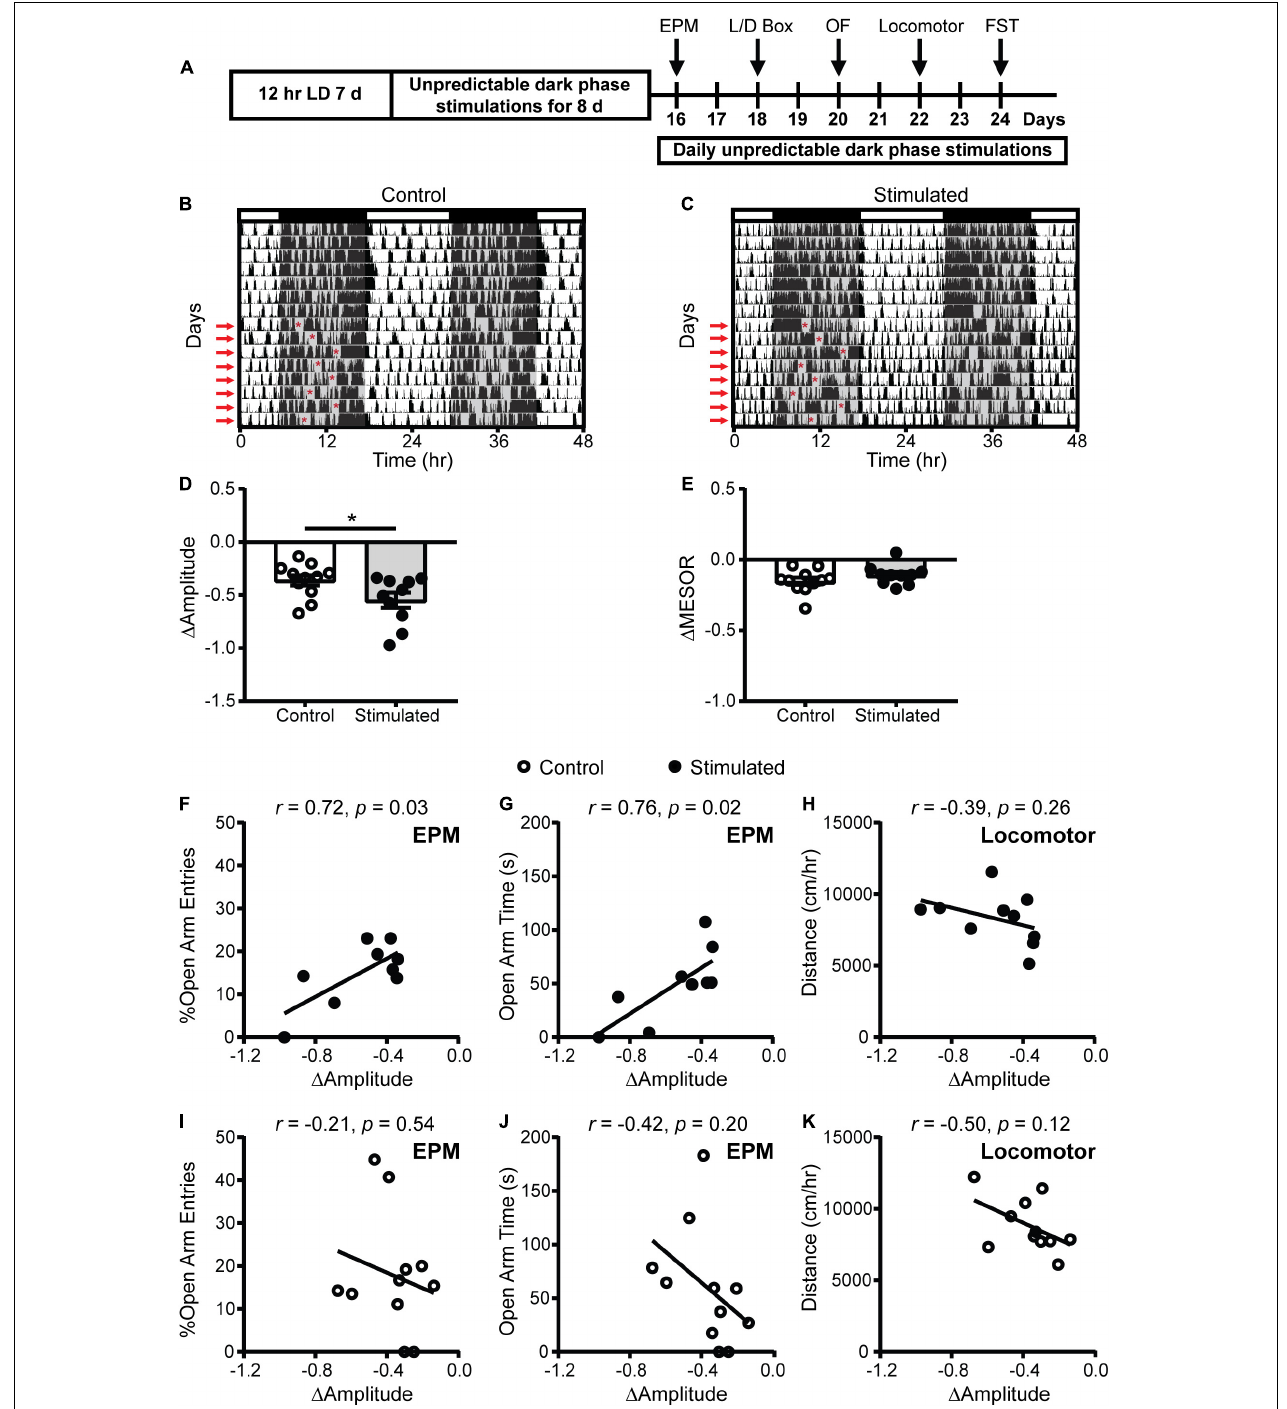
FIGURE 3 | Homecage circadian activity changes and correlations with behavior in mice that received stimulations or sham stimulations of the SCN at unpredictable times during the dark phase. (A) Experimental design. (B,C) Representative double-plotted actograms of homecage activity of a control and stimulated mouse. Gray shading indicates when lights were off and red arrows indicate when the daily stimulations took place. The red asterisks on the left sides of the actograms indicate the times of the stimulations. Change in homecage activity circadian parameters were measured relative to baseline in LD. (D) Stimulated mice exhibited a greater reduction in homecage activity amplitude. (E) There was no difference in the change in midline estimating statistic of rhythm (MESOR) between control and stimulated mice. Correlations between change in homecage activity amplitude and (F,G,I,J) EPM and (H,K) locomotor behavior in mice that received daily unpredictable dark phase stimulations or sham stimulations of the SCN. n = 9–11 Vgat-Cre;ChR2 mice . * p < 0.05.